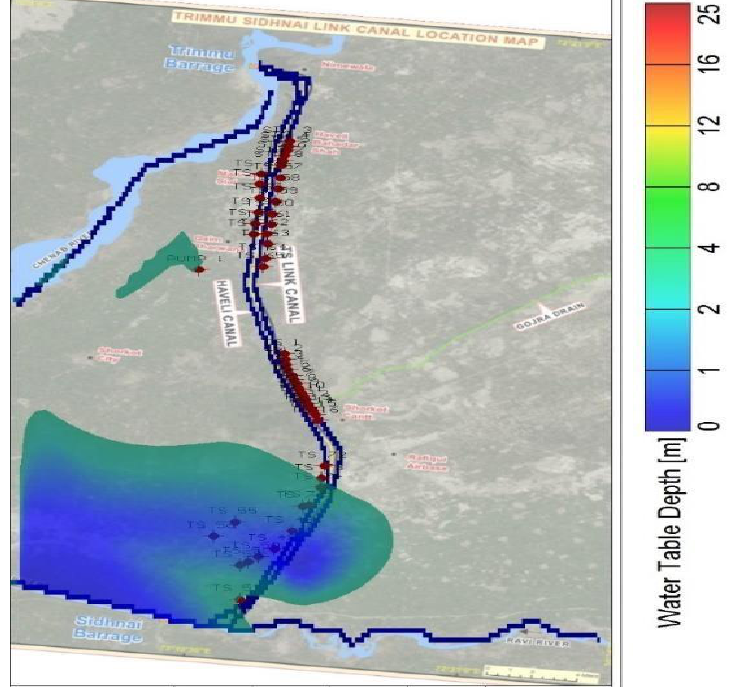
Figure 8. Simulated Depth to Water Table under Intervention